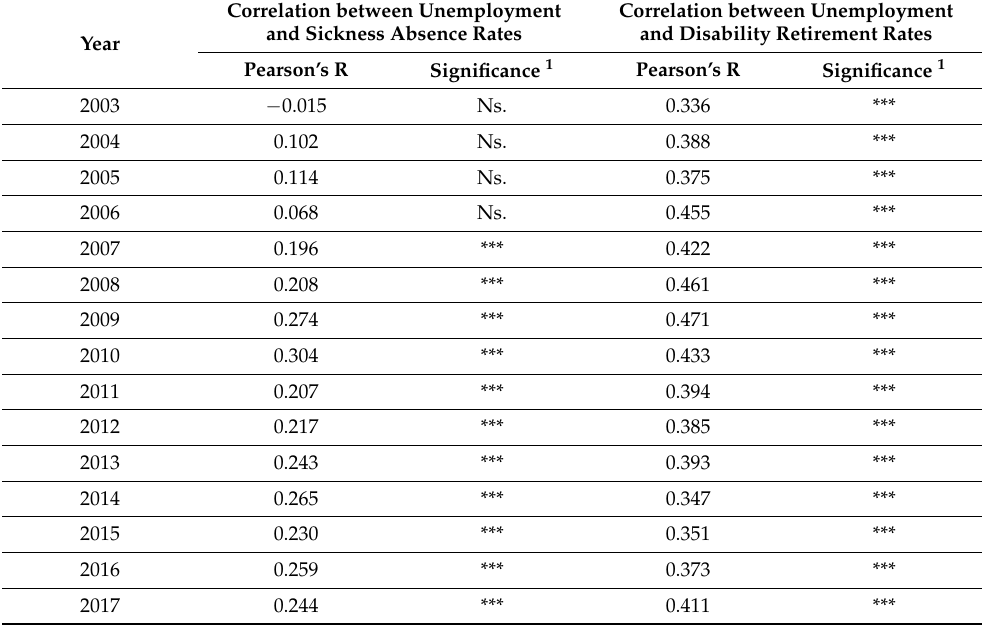
Table 2. Cross-sectional yearly correlations of municipality-level unemployment rates with sickness absence and disability retirement rates in 2003–2017. Correlation between Unemployment Correlation between Unemployment and Sickness Absence Rates and Disability Retirement Rates Year Pearson’s R Significance 1 Pearson’s